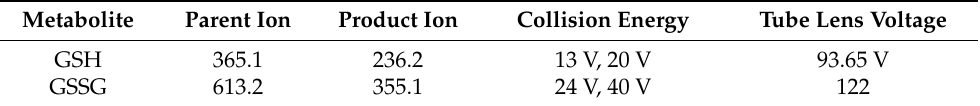
Table 2. Selected reaction monitoring parameters for the glutathione